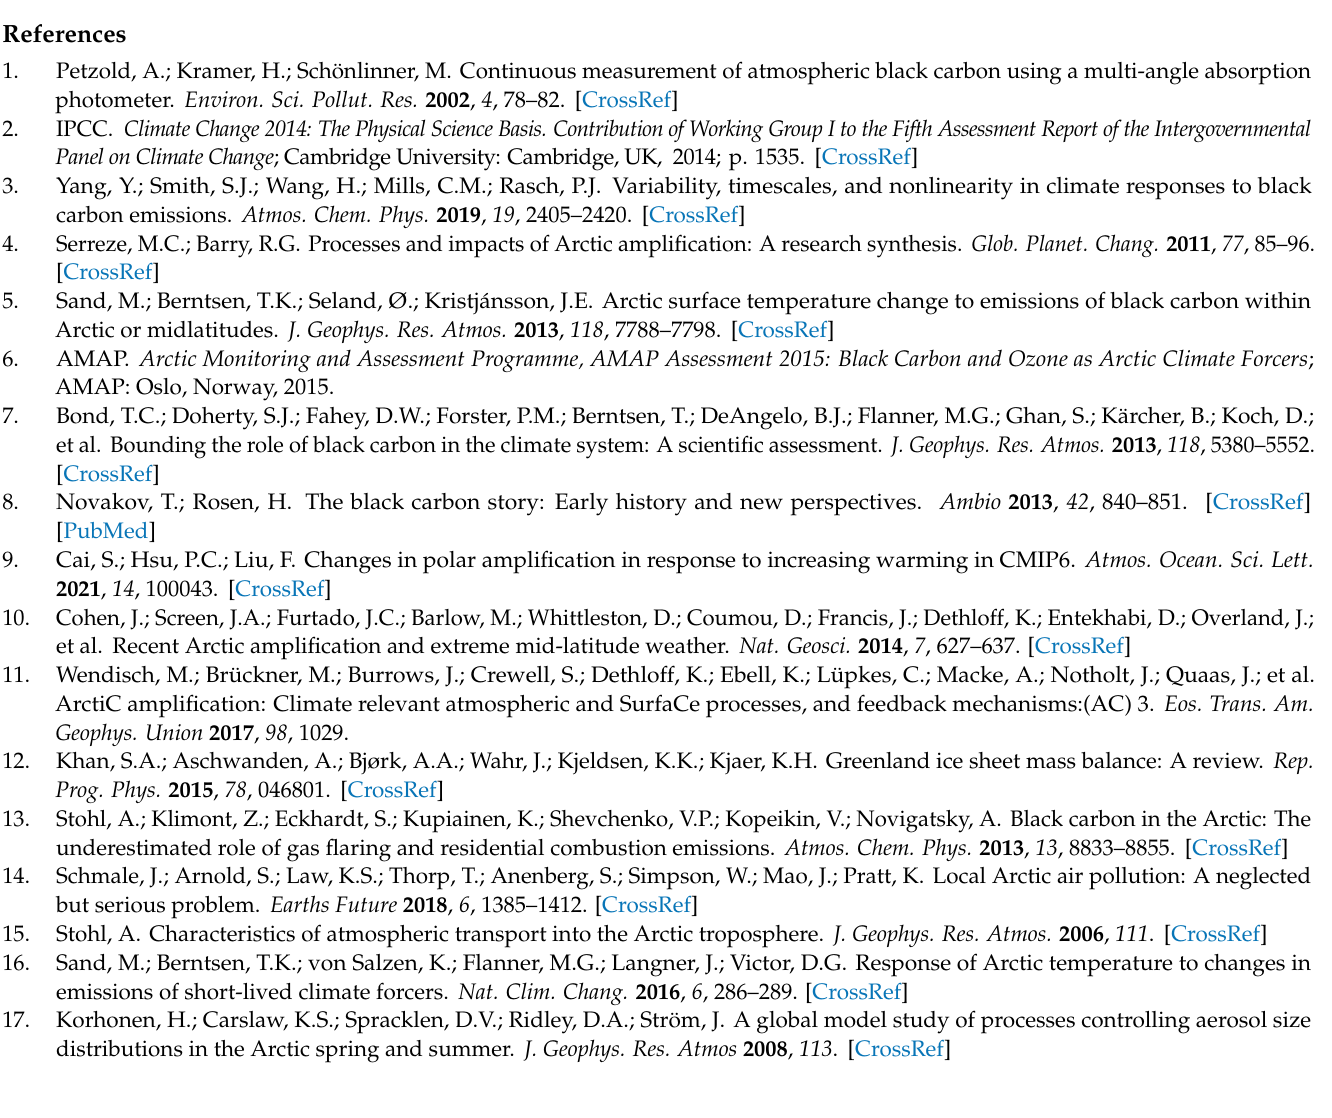
Figure A5. Mean burnt area [m 2 ] from the GFED fire emission database for the study period 2002– 2010, ( a ) the haze months March to May and ( b ) all month of the period